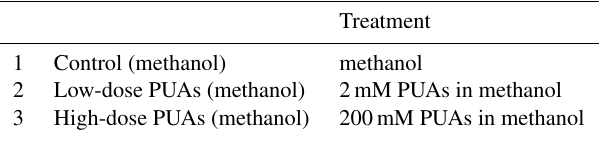
Table 1. Summary of treatments in the experiments of exogenous PUA additions for the low-oxygen waters at station Y1 during June 2019. The PUA solution includes heptadienal (C7_PUA), octadi- enal (C8_PUA), and decadienal (C10_PUA) with the mole ratios of 10 : 1 : 10.